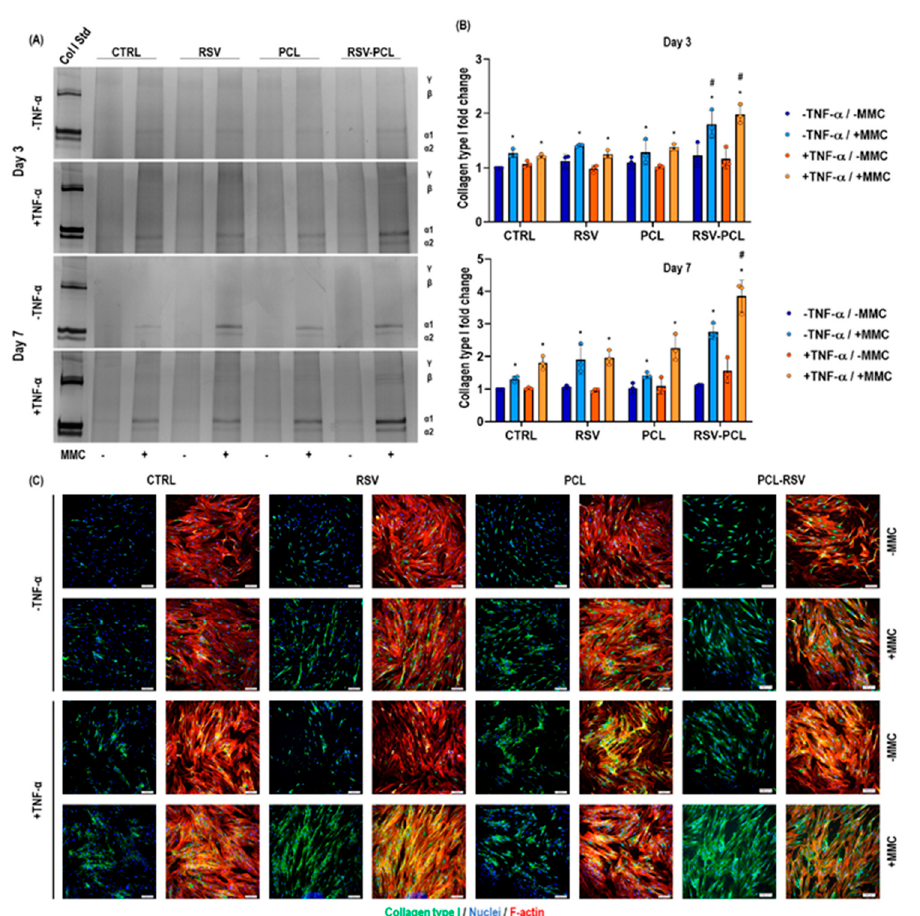
Figure 5. Effect of 0% RSV-PCL (PCL) and 10% RSV-PCL (RSV-PCL) electrosprayed microparticles on collagen type I deposition of human dermal fibroblasts. SDS-PAGE ( A ) and complementary densitometric analysis ( B ) revealed that at all time points (3 and 7 days), RSV-PCL microparticles (100 μ g/mL), in the presence of TNF- α stimulation (50 ng/mL) and MMC conditions (Ficoll 70 kDa: 37.5 mg/mL; Ficoll 400 kDa: 25 mg/mL), induced the highest ( p < 0.05) collagen type I